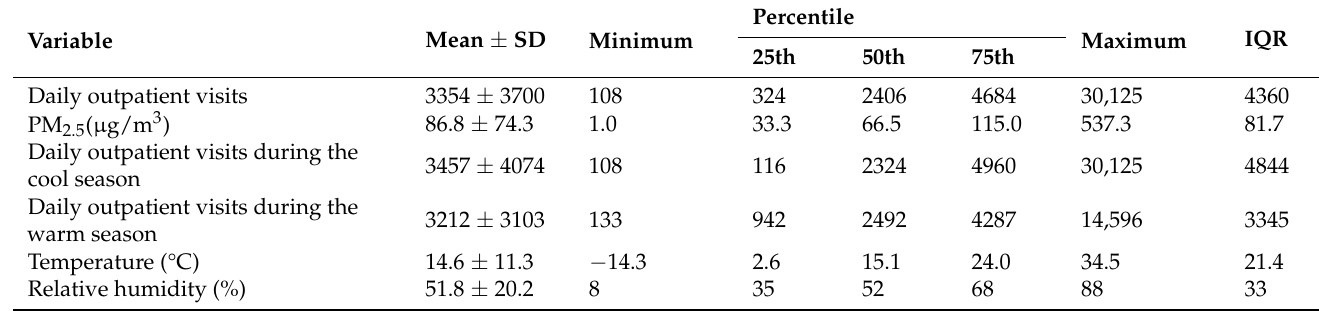
Table 2. Daily values of outpatient visits for knee osteoarthritis, PM 2.5 concentrations, and environmental parameters. Variable Mean ± SD Minimum